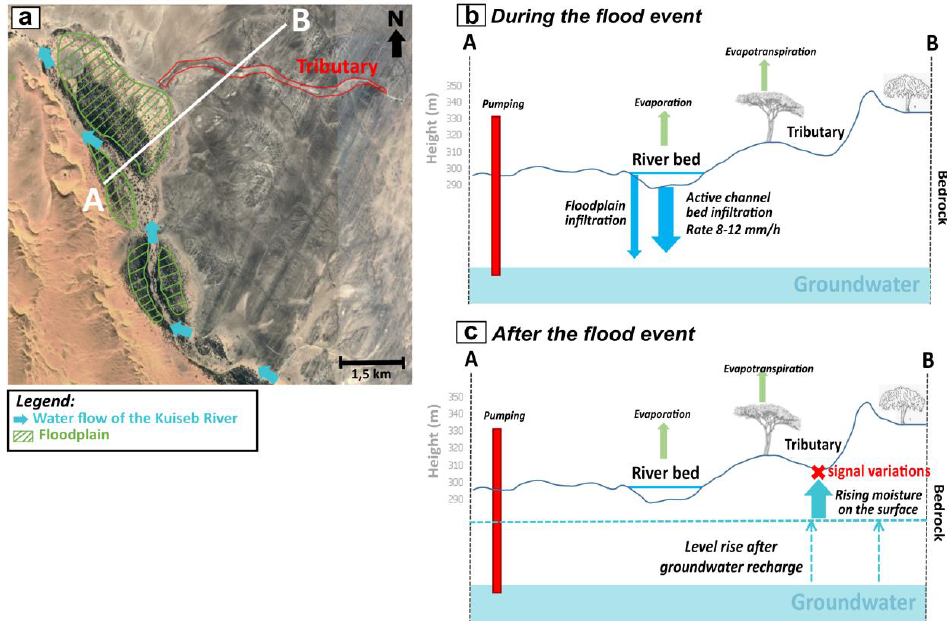
Figure 9. ( a ) Google Earth image showing the tributary outlined in red, floodplains outlined in green, and the direction of the water flow in the Kuiseb River during a flood event. The white line is a transect across the Kuiseb River and its tributary at Klipneus. ( b ) Idealised topographic section along a transect (white line in a) to illustrate likely hydrological consequences during and ( c ) after a flood event in the main river channel and the tributary that leads to a reduction in radar image coherence.